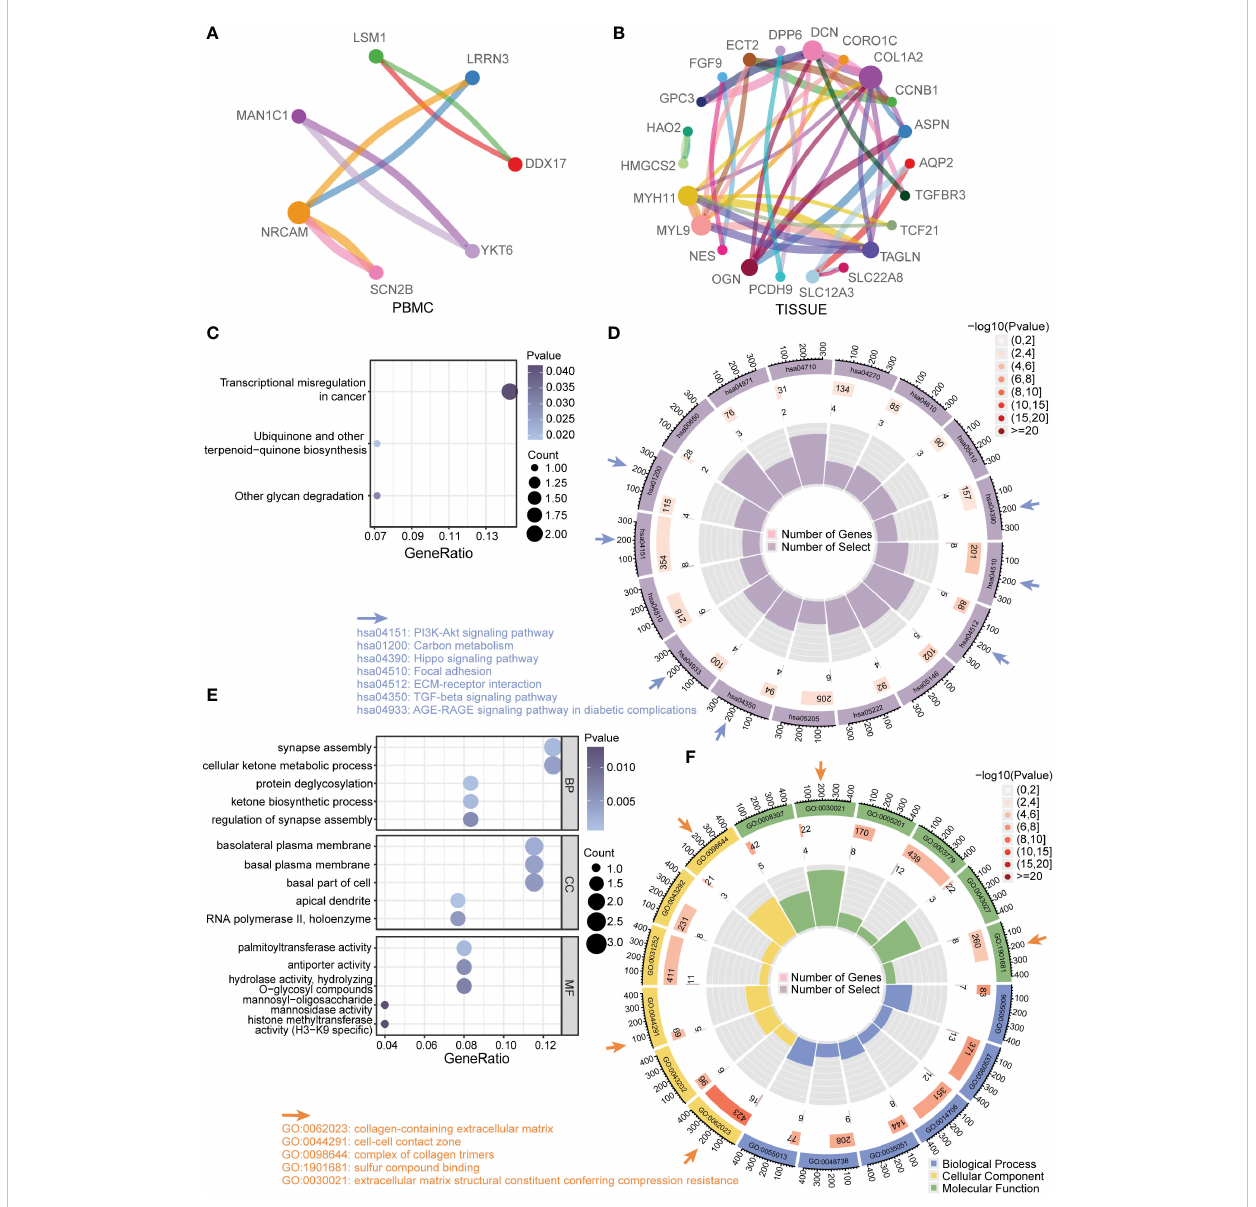
FIGURE 3 Functional enrichment analysis of DEGs (A) Protein – protein interaction (PPI) network of total DEGs from PBMC. Different colors of dots in the circle plot represented different proteins. The connectivity degree was represented by dot size. The edge width was proportional to combined score. (B) PPI network of total DEGs from TISSUE samples. (C) Enriched KEGG pathways among PBMC DEGs. The gene ratio was represented on the horizontal axis. The vertical axis indicated the KEGG signaling pathway terms, and the purple-to-blue gradually changing color indicated the change of signi fi cance from low to high. (D) Circular enrichment of KEGG pathways among TISSUE DEGs (hsa04510: Focal adhesion; hsa04512: ECM-receptor interaction; hsa05146: Amoebiasis; hsa05222: Small cell lung cancer; hsa05205: Proteoglycans in cancer; hsa04350: